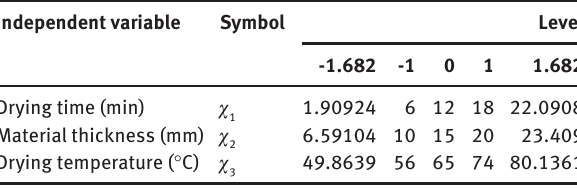
Table 1: Factors and levels coding of response surface